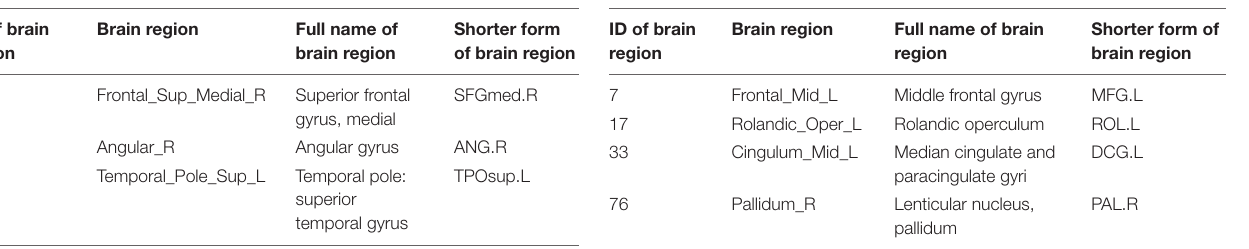
TABLE 3 | The brain regions with a frequency of 10.